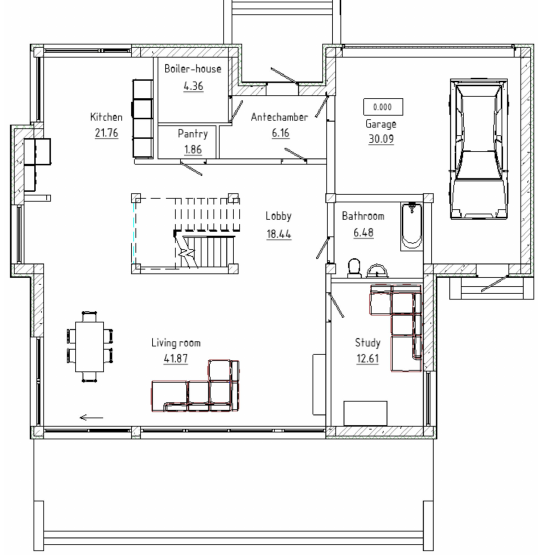
Figure 15. Plan of the first floor.